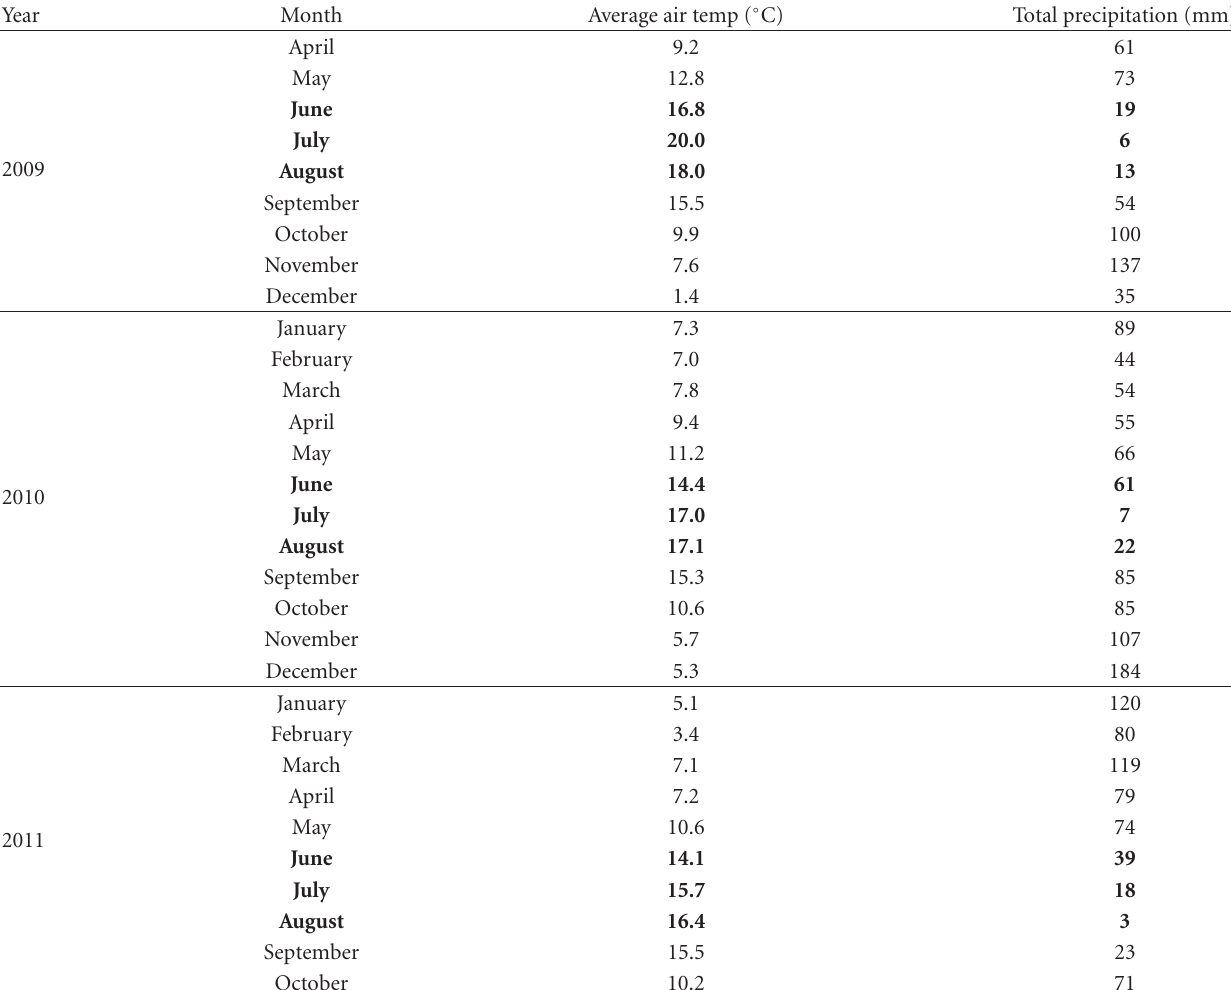
Table 1: Average air temperature and total precipitation by month beginning at the start of plot implementation through the 3rd growing season.